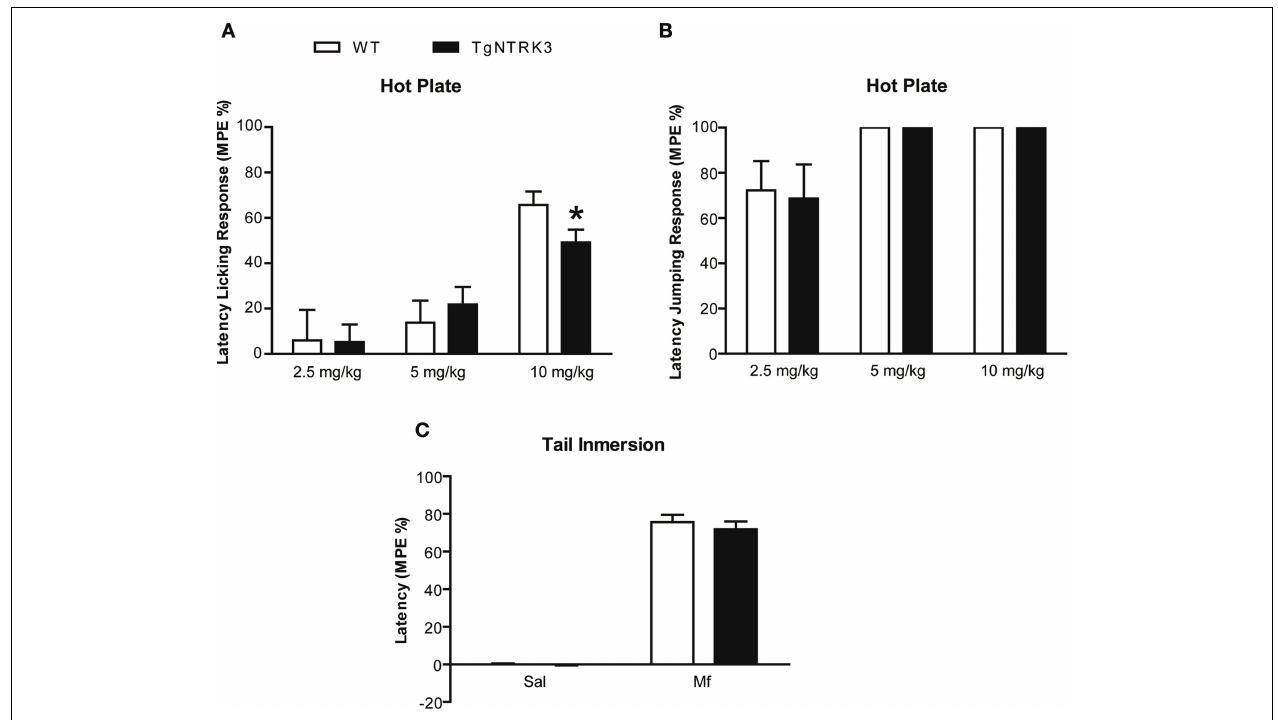
FIGURE 1 | Acute antinociceptive effect of morphine (Mf, 10 mg/kg, s.c.). Two behavioral tests were used in WT (white bars) and TgNTRK3 (black bars): the hot plate test in which (A) the licking and (B) the jumping threshold were recorded, and (C) the tail immersion test where the